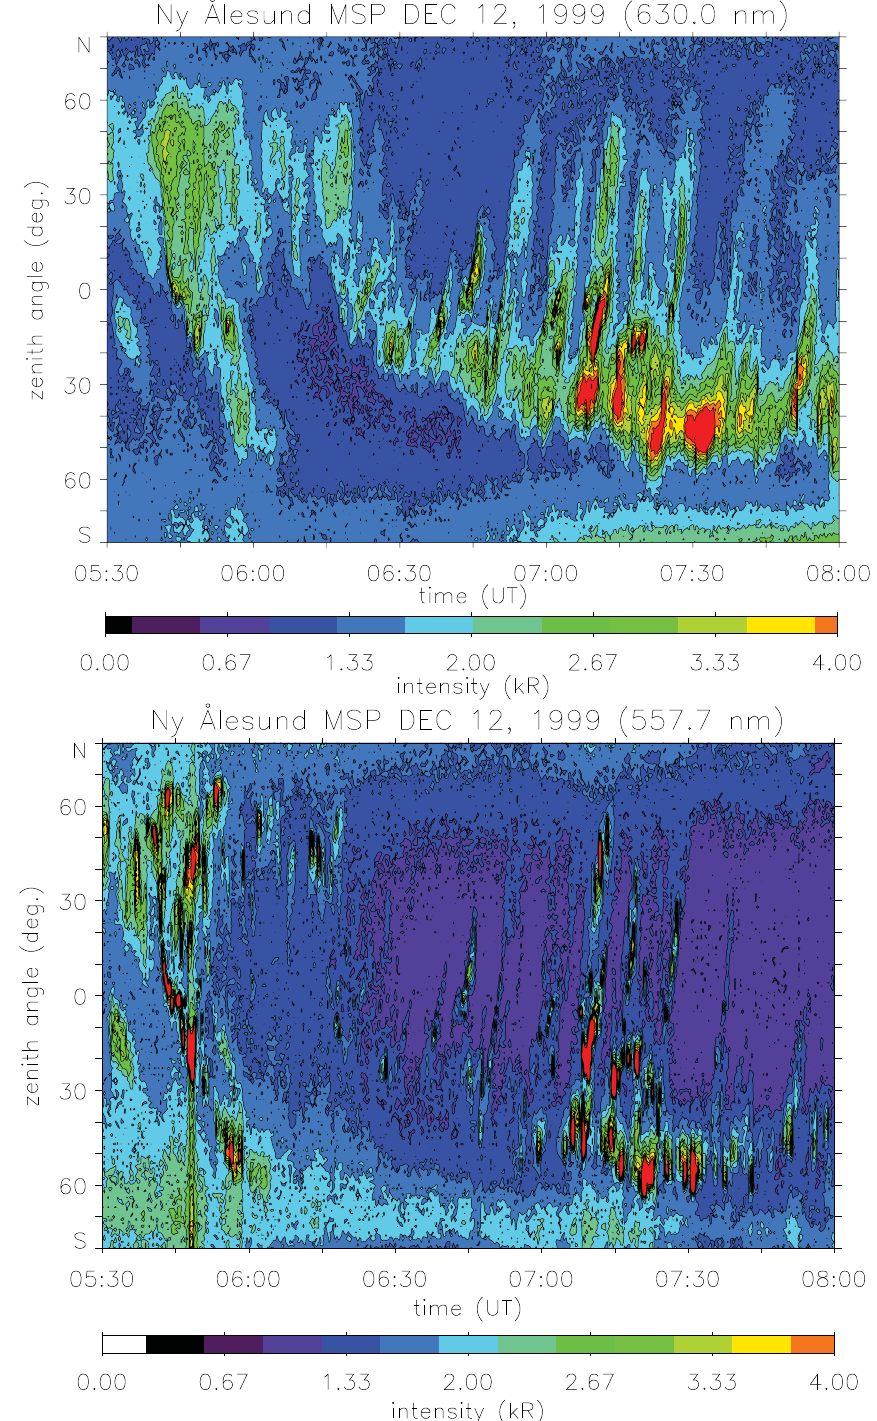
Fig. 13. MSP data from Ny ˚Alesund for the interval 05:30–08:00 UT. The red and green auroral lines at 630.0 and 557.7nm are shown in the upper and lower panels, respectively. Same format as in Fig. 2.